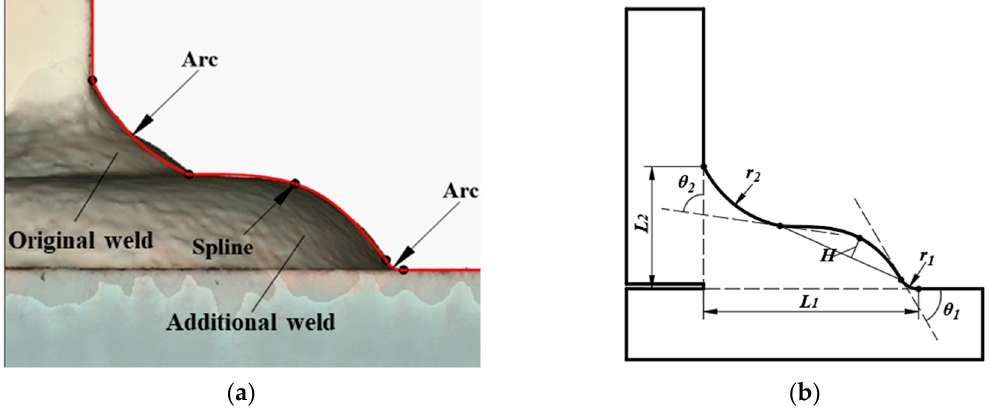
Figure 8. Extension to the additional weld: ( a ) the additional weld; ( b ) the modified spline model.